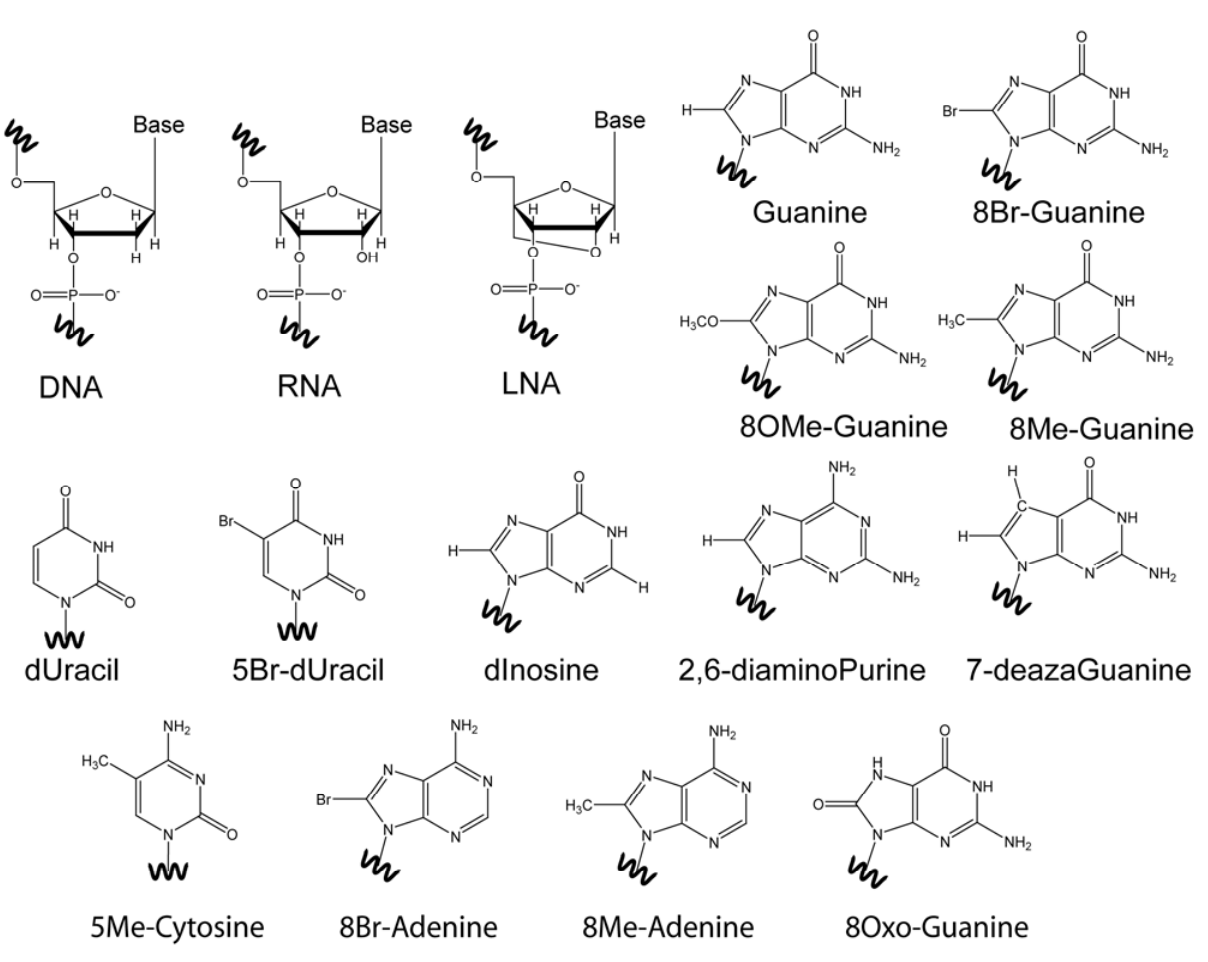
Figure 1. Chemically modified nucleobases utilized in solution NMR structure